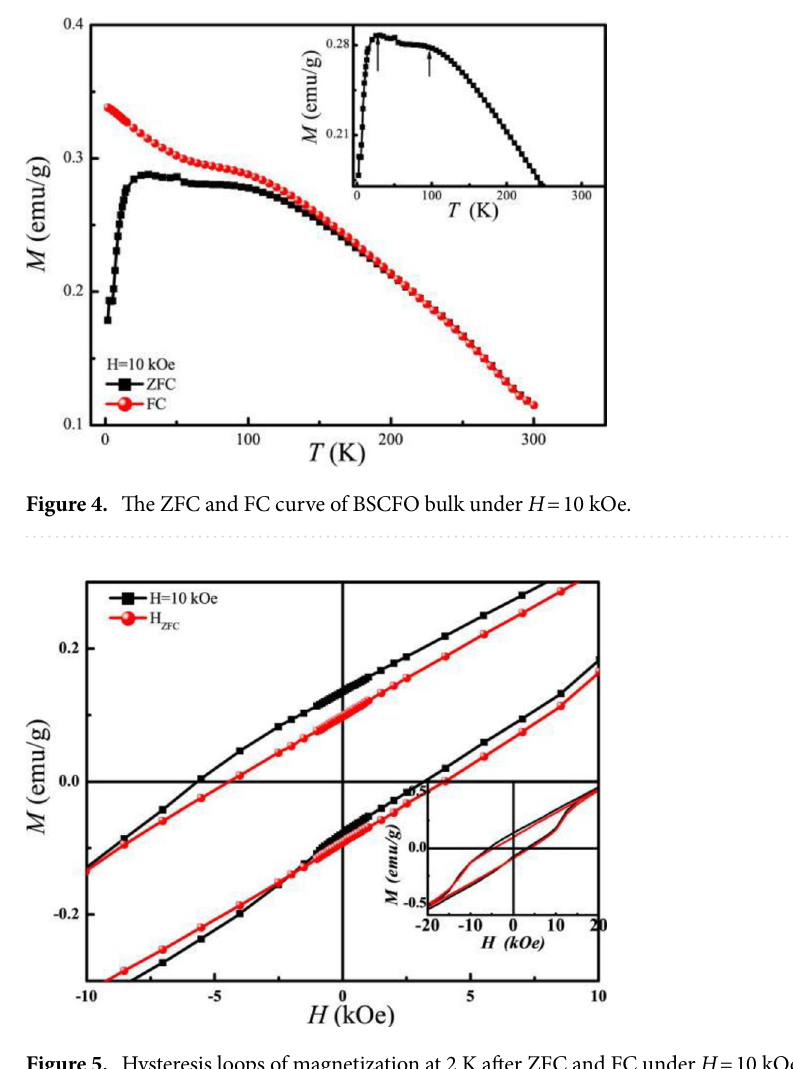
Figure 5. Hysteresis loops of magnetization at 2 K after ZFC and FC under H = 10 kOe from 300 K. The inset is the enlarged graph of hysteresis loop.